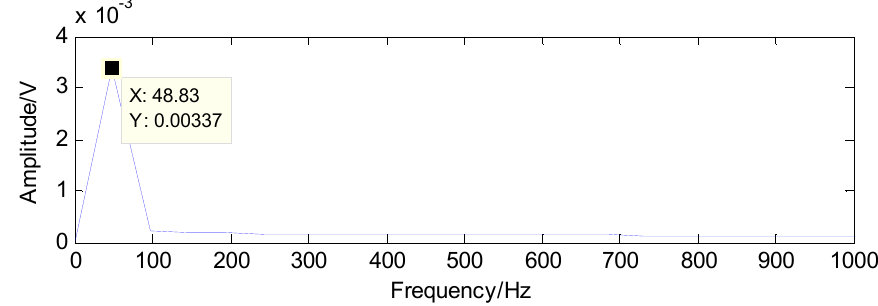
Figure 20. Second detection result using the raw signals based on the method in [37].